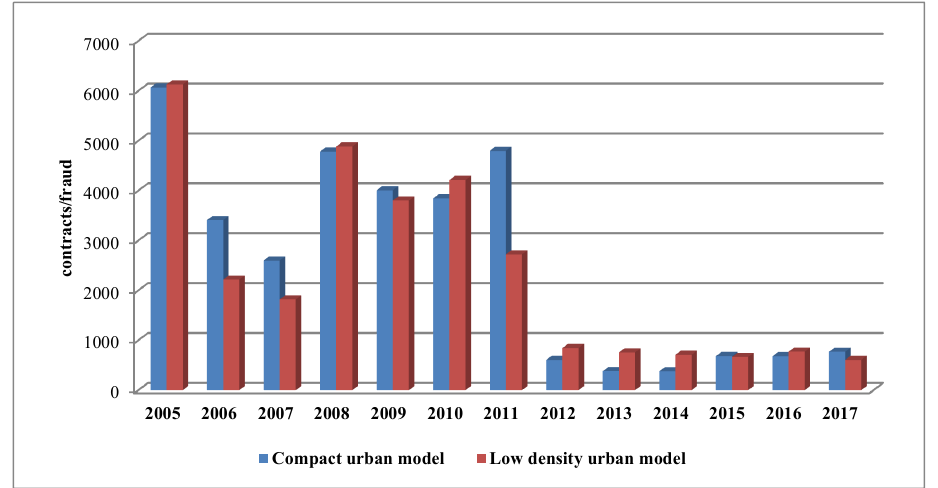
Figure 2. Evolution of the ratio contracts/fraud detected in the city of Alicante according to urban development typology (2005–2017). Source: AMAEM. Own elaboration.